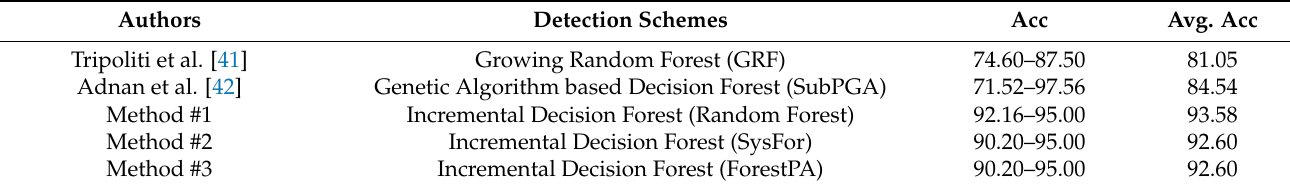
Table 13. Comparison of the proposed approach with other state of the approaches having similar functionality and